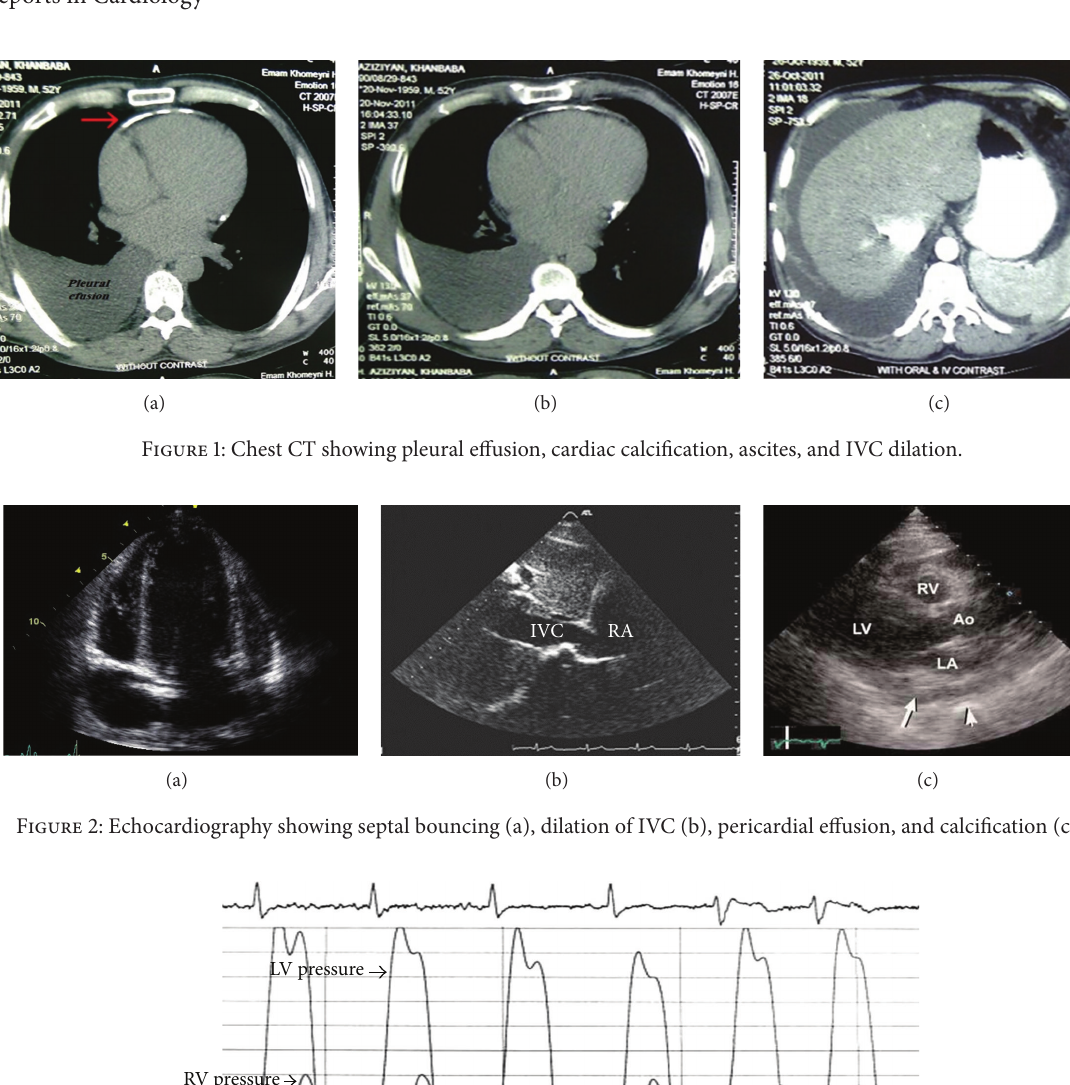
The arrows indicate thickened pericardium